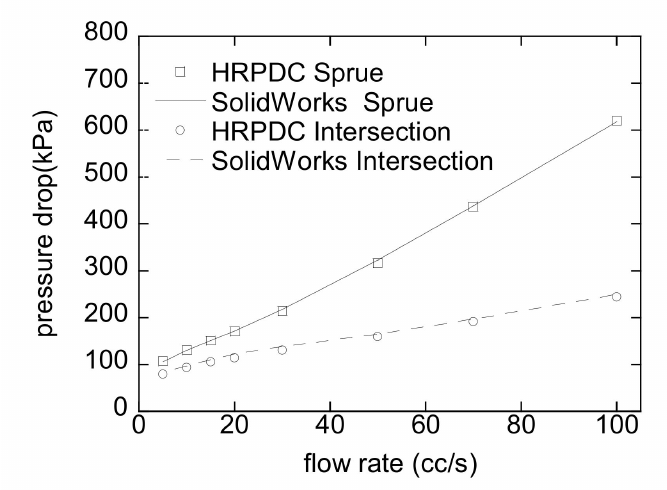
Figure 10. Comparison of the results by HRPDC and SolidWorks Flow Simulation. Refer to Figure 8 for the viscosity and Figure 9 for the dimensions.